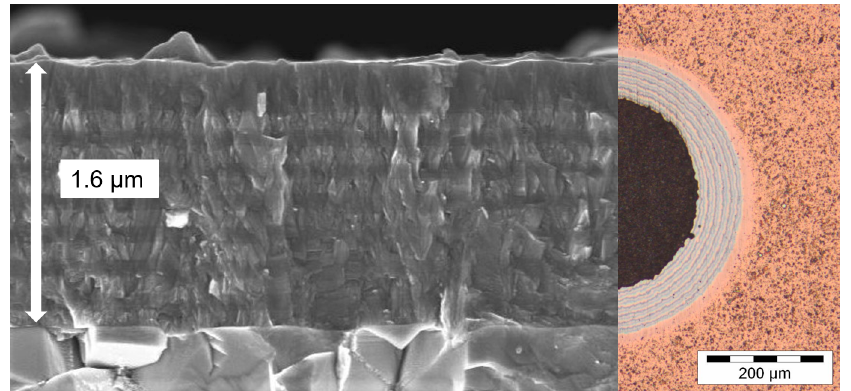
27 Figure 27. Cross section and calotte of an industrially applied arc multilayer coating (AlCr)N/(TiSi)N, with top layer of (TiSi)N, BALINIT ® HELICA, courtesy of Oerlikon